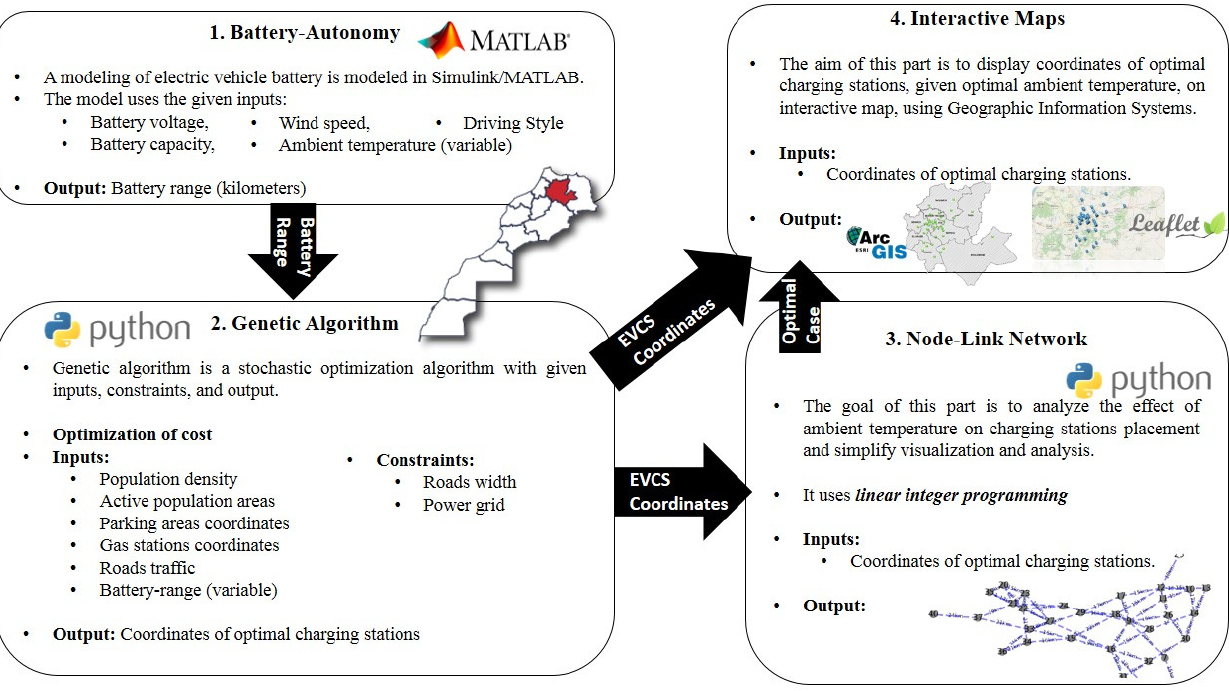
Figure 1. Research